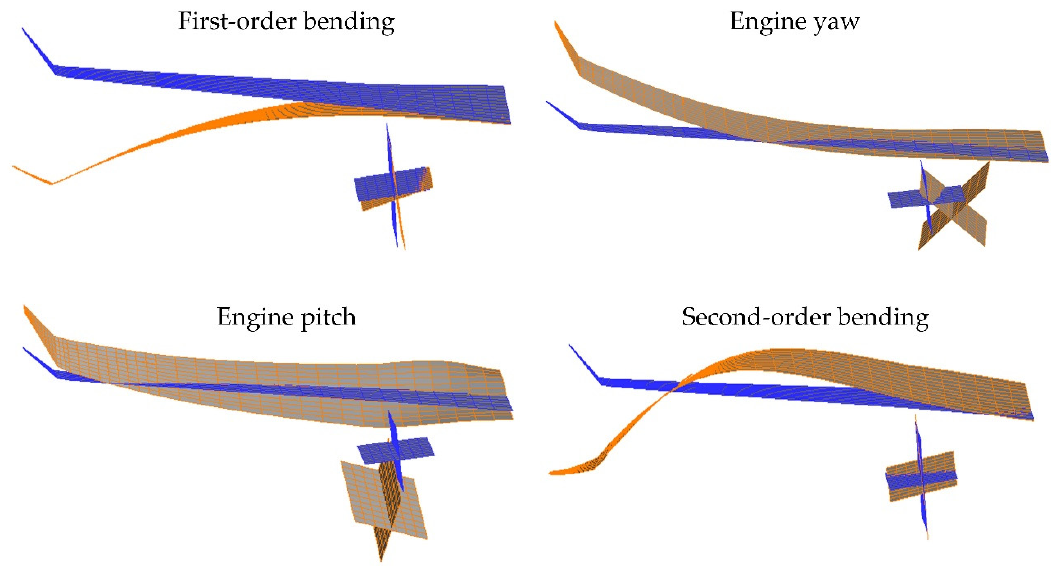
Figure 7. Interpolated structural modes on the aerodynamic model. Table 1. Comparison between the experimental and theoretical values of wing modal